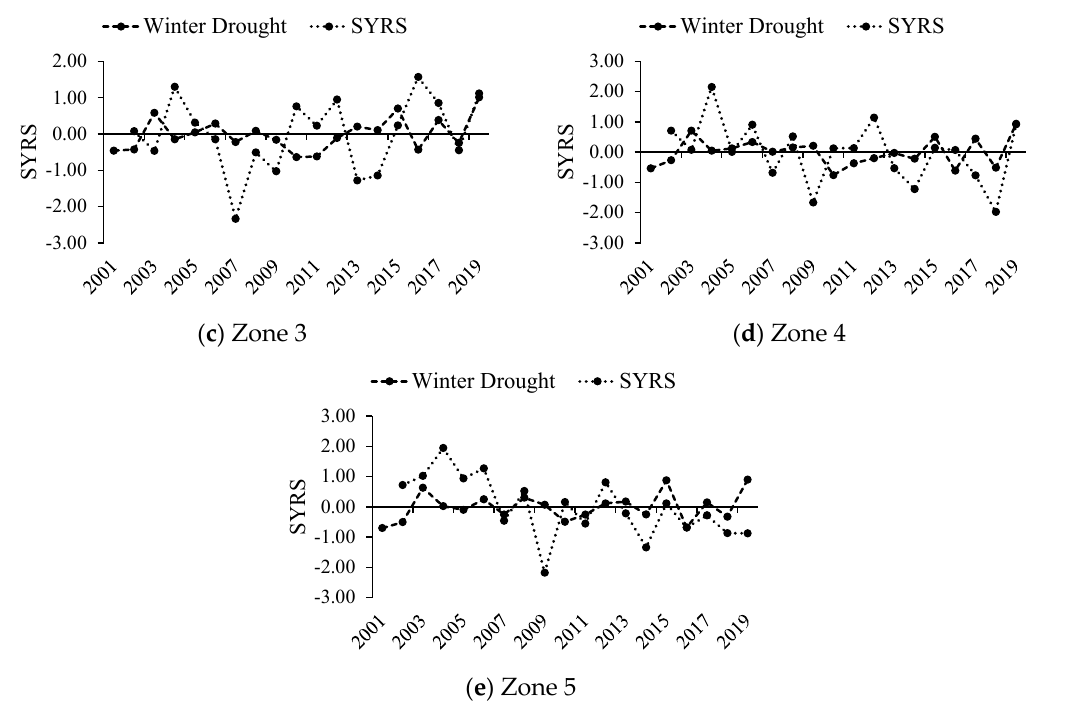
Figure 5. Temporal time series of the Standardized Yield Residual Series ( SYRS ) of the wheat crop in different zones of Punjab during 2001–2019, ( a ) Zone 1, ( b ) Zone 2, ( c ) Zone 3, ( d ) Zone 4 and ( e ) Zone 5 Table 3. Trend analysis of the yield for selected zones. Region Wheat